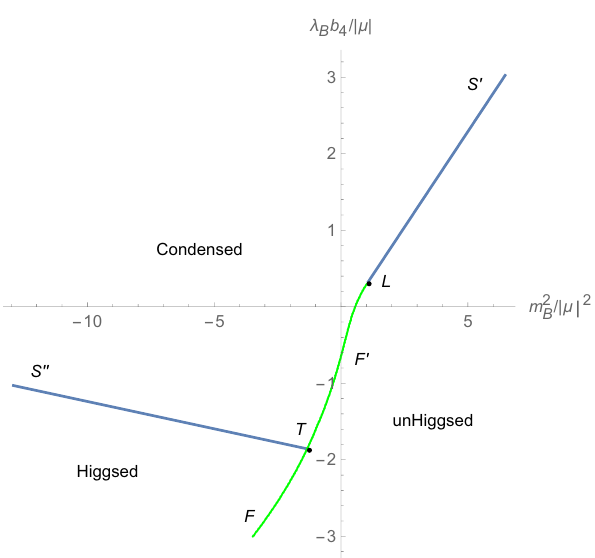
Figure 22 . The phase diagram of the regular boson theory for | λ B | = 1 is in the stable range 1